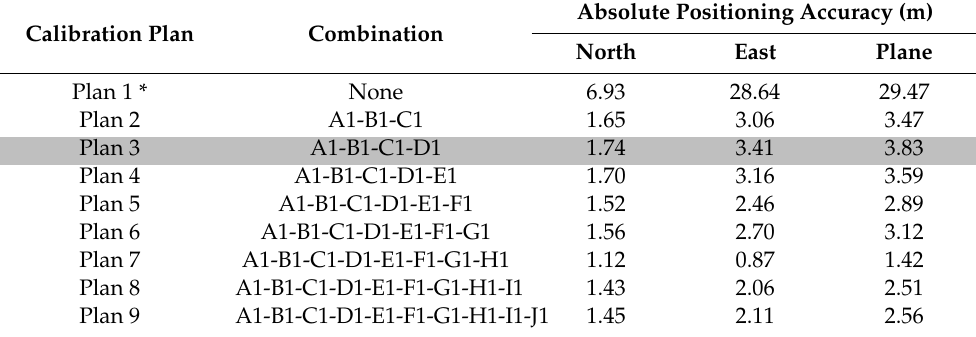
Table 7. Comparison of absolute positioning accuracy of Validation Group B before and after compensating for geometric calibration parameters.